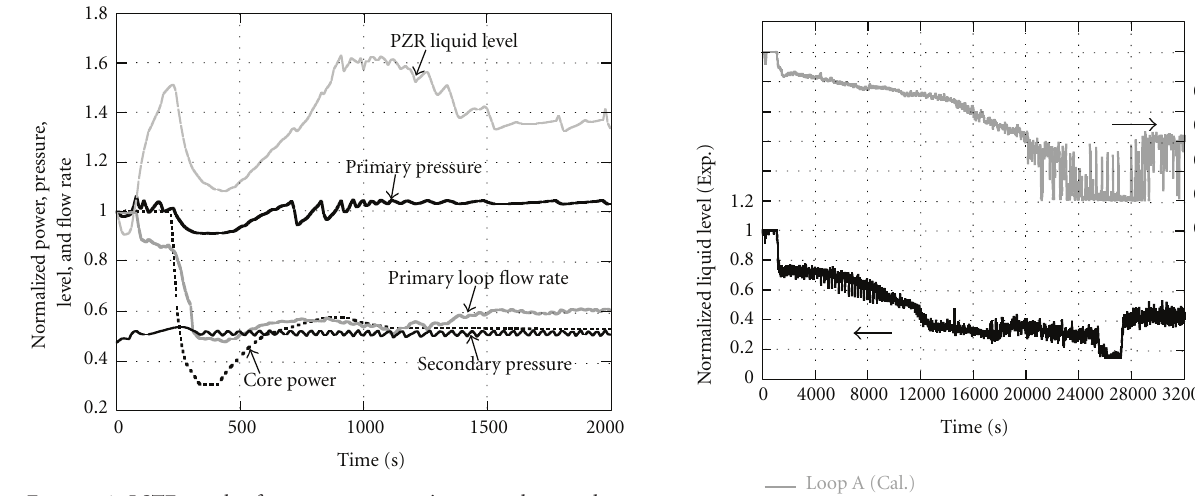
Figure 6: LSTF results for core power, primary and secondary pressures, PZR liquid level, and primary mass flow rate in loop with PZR (0 to 2000 s).